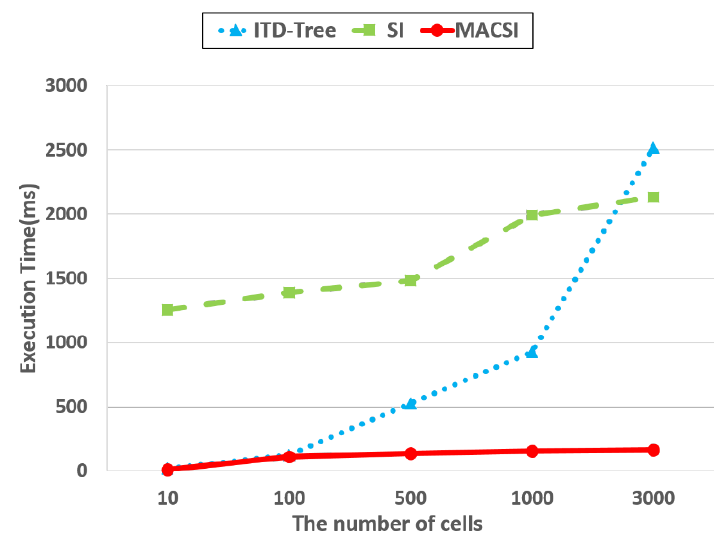
Figure 22. The effect of cell number on the fine-grained semantic object query performance.